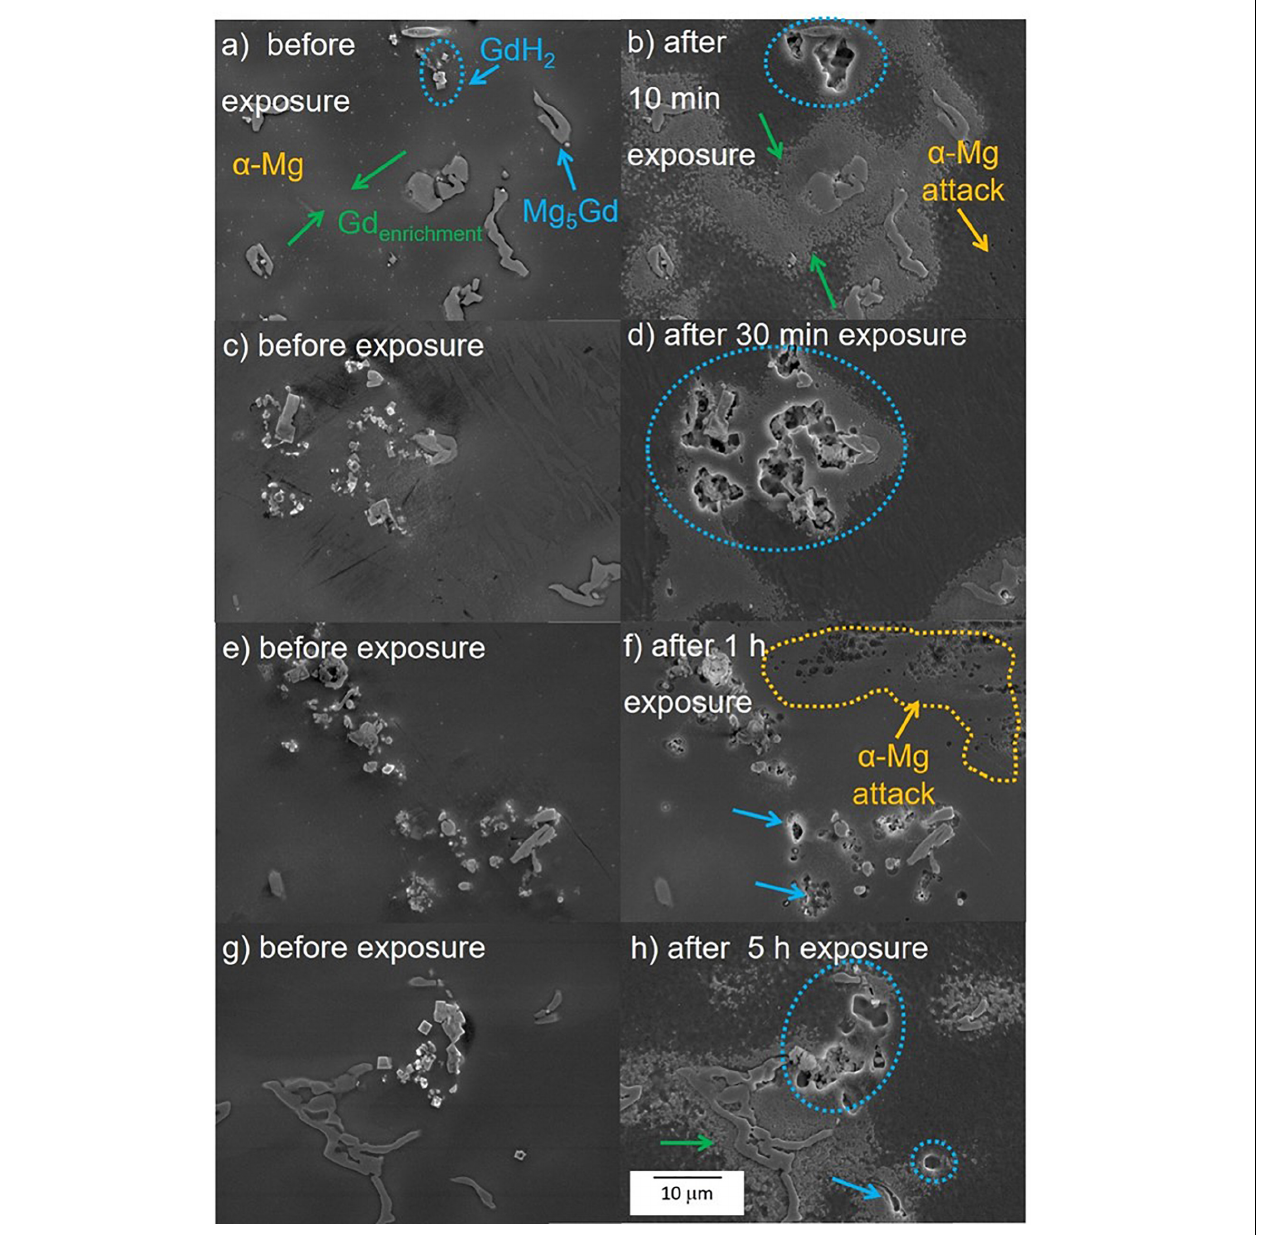
FIGURE 10 | Corrosion monitoring using drop test of as-cast Mg-10Gd alloy (a,c,e,g) before exposure and (b,d,f,h) after different exposure times in 0.5 wt. % NaCl solution. Yellow arrows/dotted areas depict the corrosion attack on the α -Mg matrix, blue arrows/dotted circles indicate corrosion process on the Mg 5 Gd/GdH 2 phases and the green arrows show the corrosion degradation on the Gd enrichment areas.